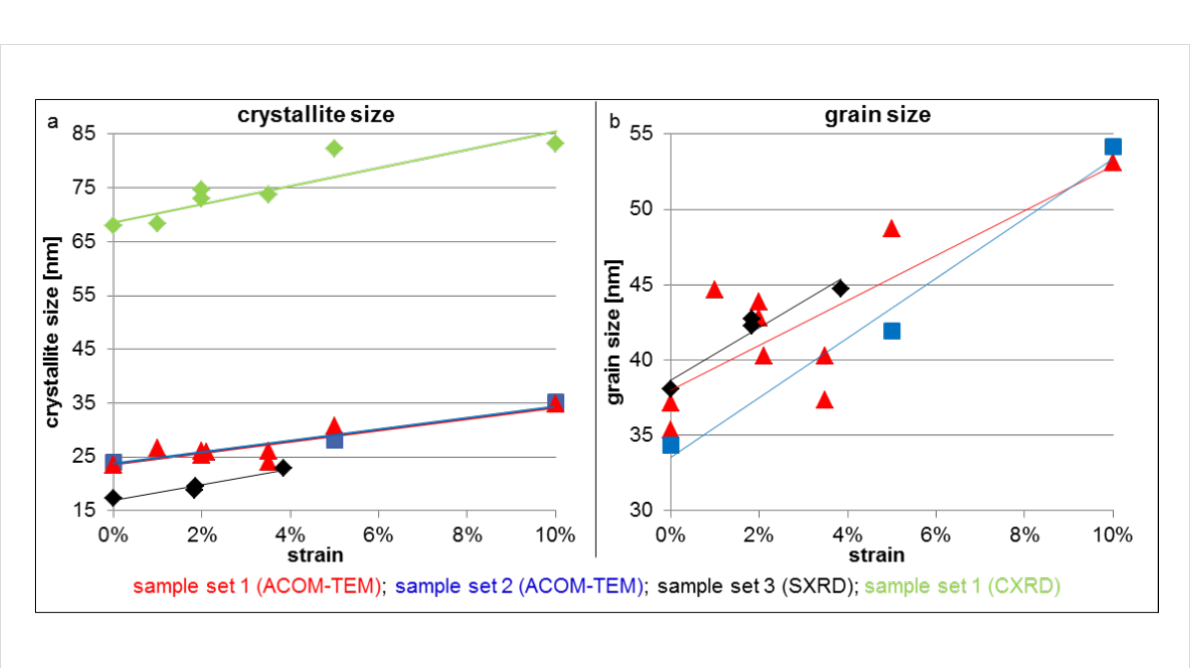
Figure 4: Crystallites recognized by ACOM-TEM for the as deposited sample and samples deformed to 5% and 10% strain (a–c). d–f) Crystallite boundaries (black), twin boundaries (CSL Σ 3) (blue) and CSL Σ 9 boundaries (red).